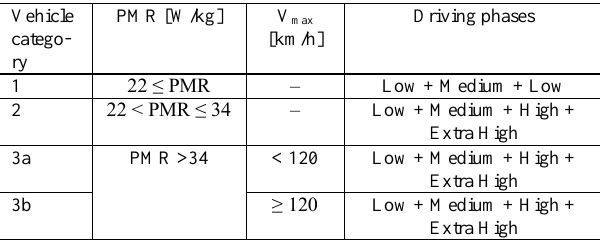
Table 1. WLTC test cycles for conventional vehicles [17]